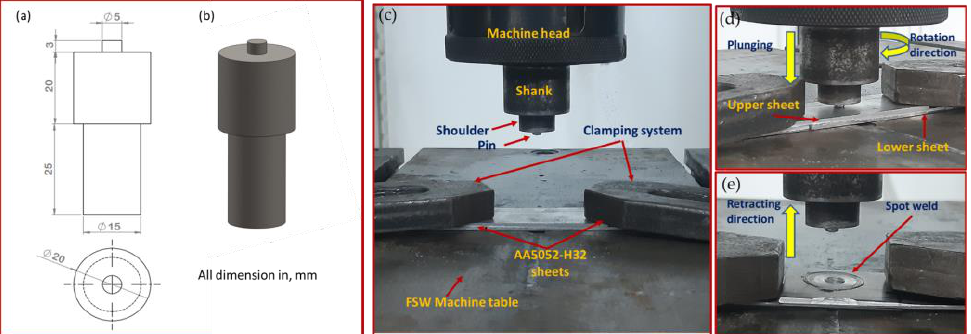
Table 2. Mechanical properties of the AA5052-H32 alloy starting material. Alloy